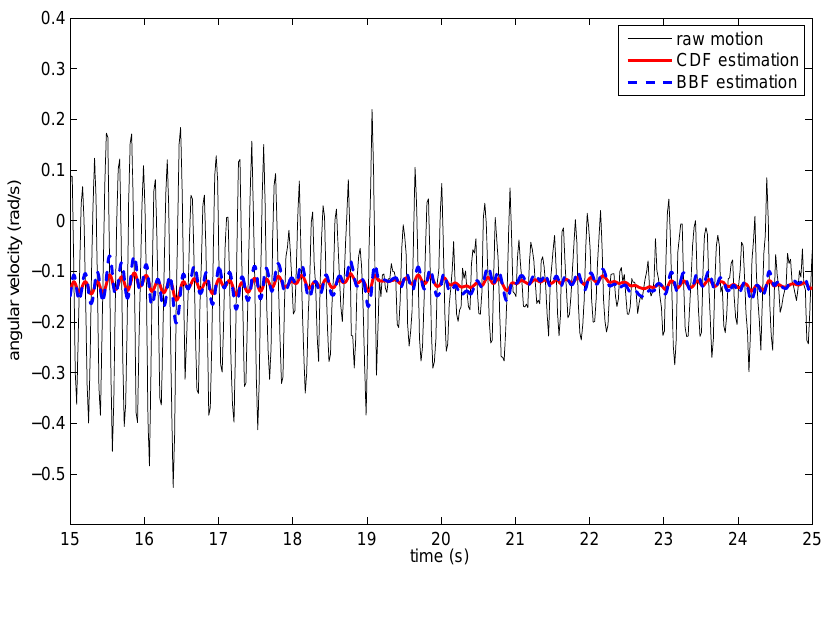
Figure 6 . Comparison between CDF and BBF estimation of voluntary movement from raw gyroscope data during an arms outstretched test performed by patient